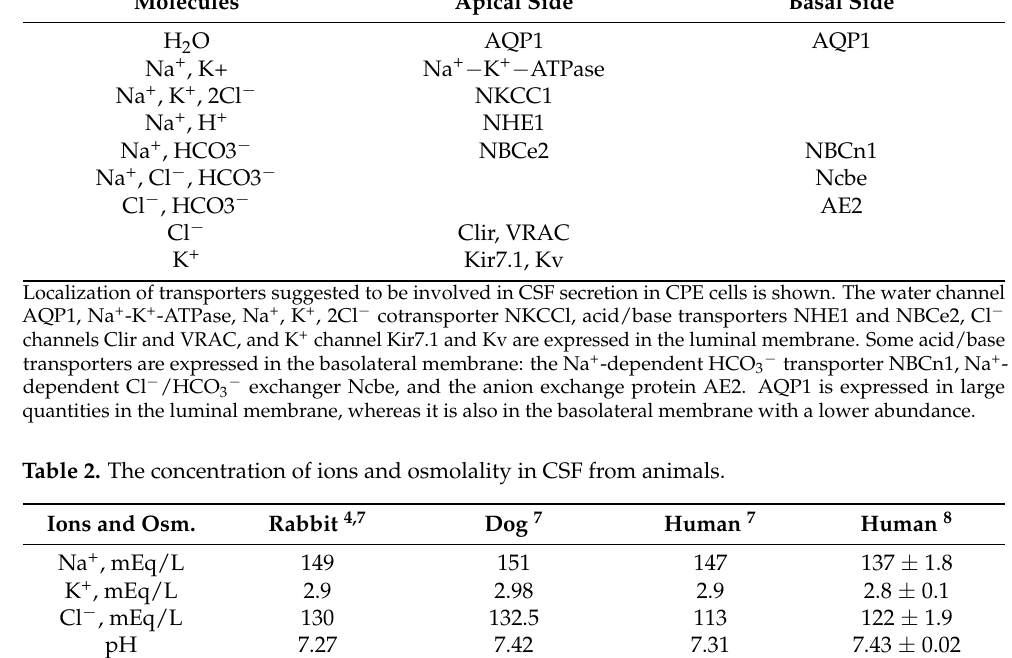
Table 1. Transporters supposed to be involved in CSF secretion in CPE cells. Molecules Apical Side Basal Side H 2 O AQP1 AQP1